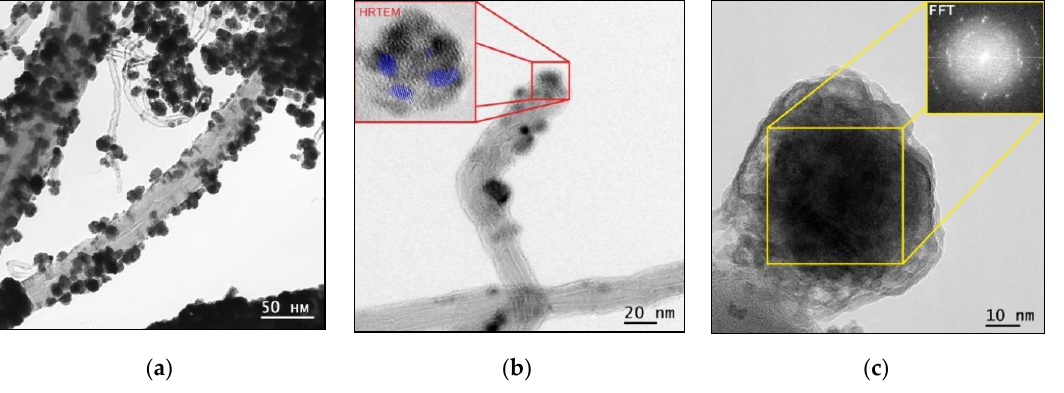
Figure 4. The TEM images of ( a ) WC 1-x /MWCNTs, ( b ) WC 1-x /MWCNT with the HRTEM insert, and ( c ) the HRTEM image of WC 1-x nanoparticles with the fast Fourier transform (FFT) insert (sample 1).